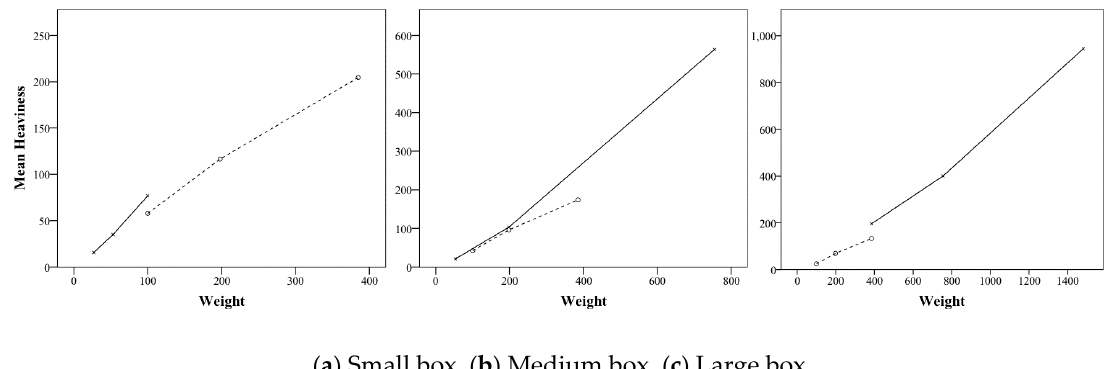
Figure 6. Mean perceived weight of weights for each box size (the dashed line is the first experiment, and the solid line is the second